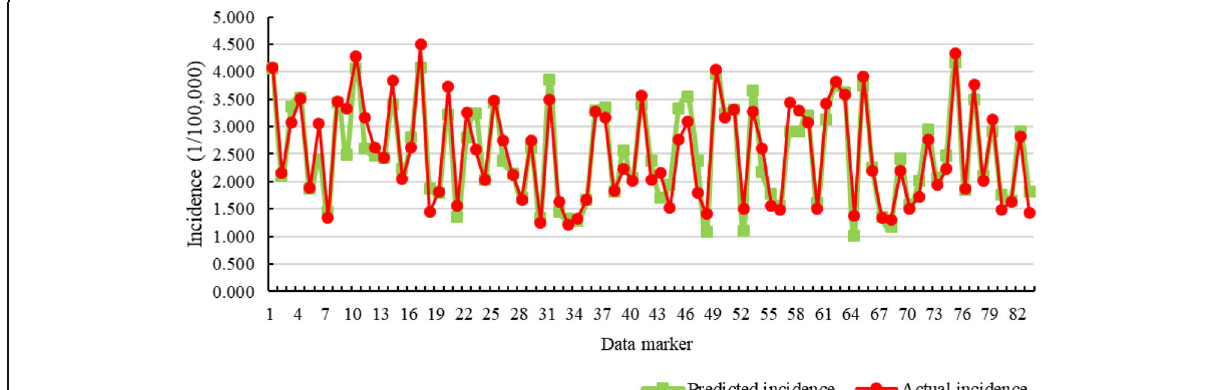
Fig. 7 The incidence predicted by the GA_SVR_MONTH model and the actual incidence: the 10th randomly selected training and test data